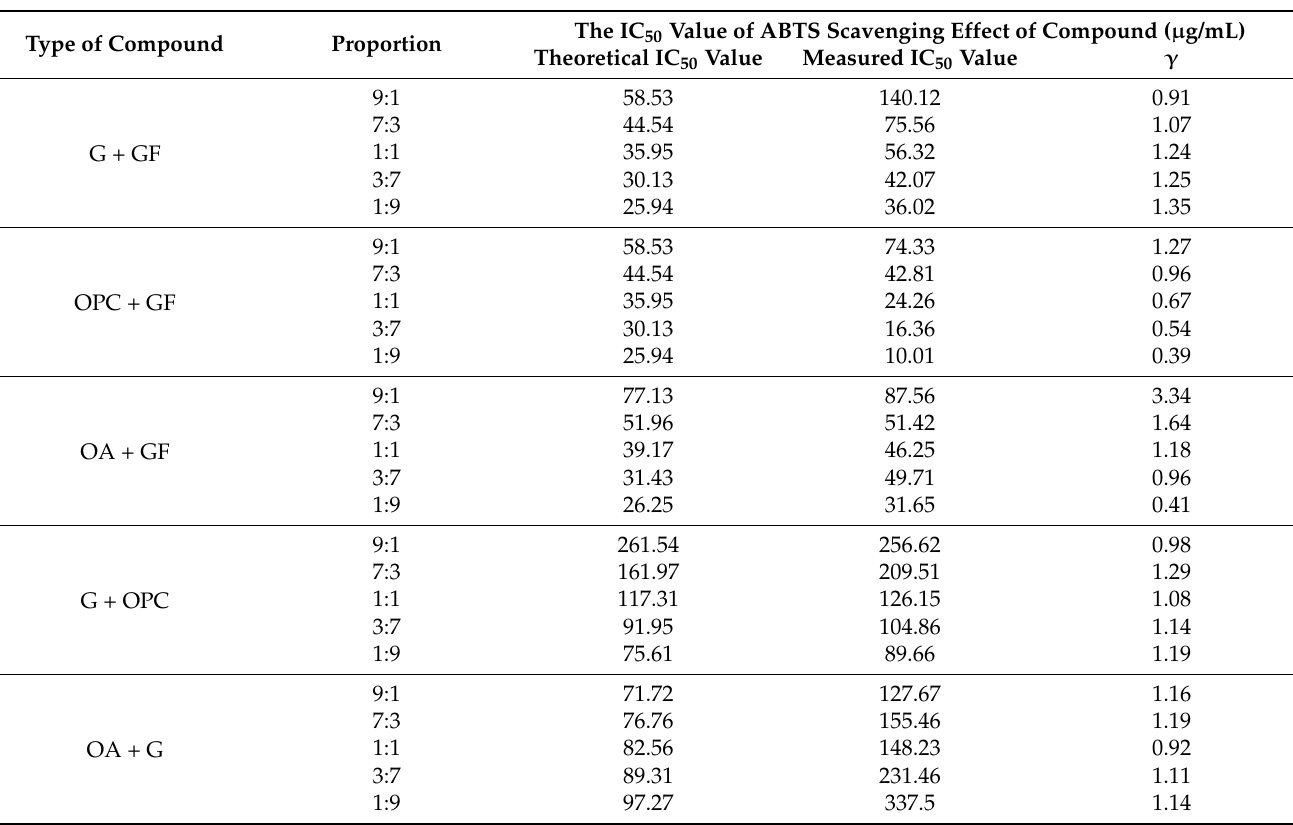
Table 4. Synergistic effect of functional components of EGb scavenging ABTS free radical.